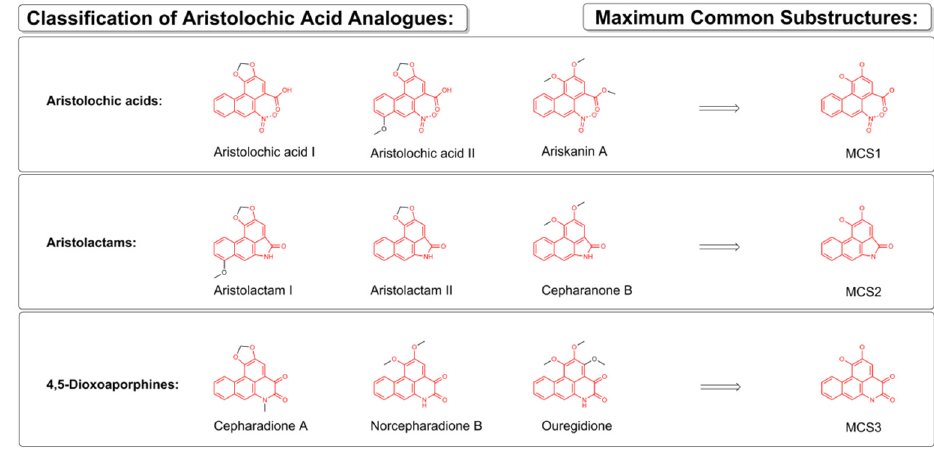
Figure 1. The classification and maximum common substructures of aristolochic acid analogues.